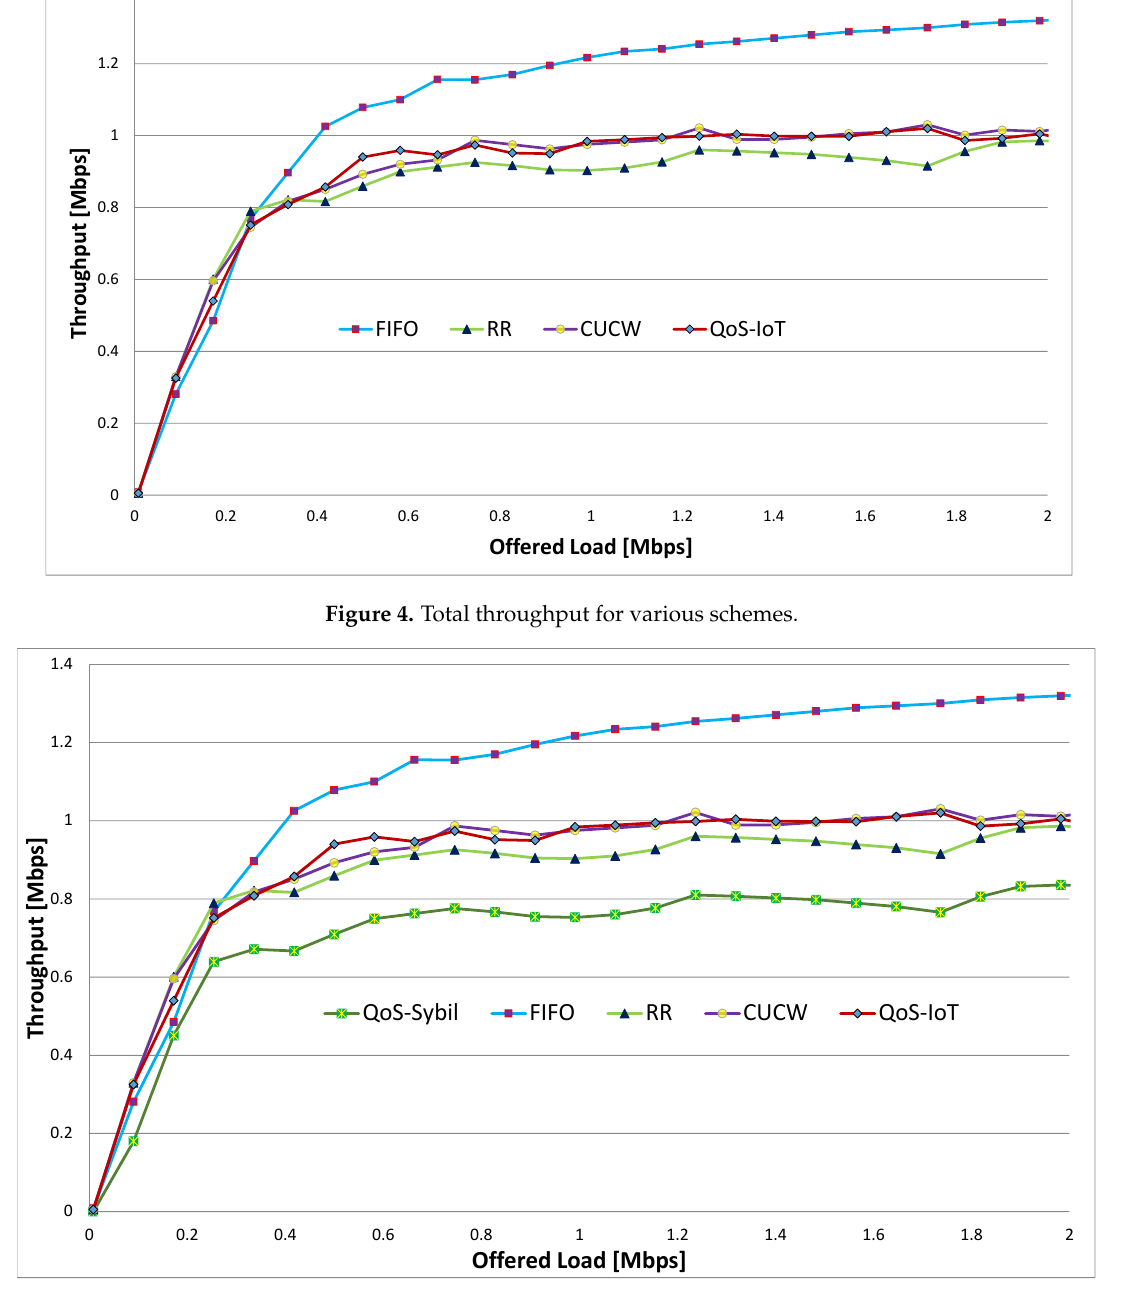
Figure 5. Total throughput and the affect of Sybil